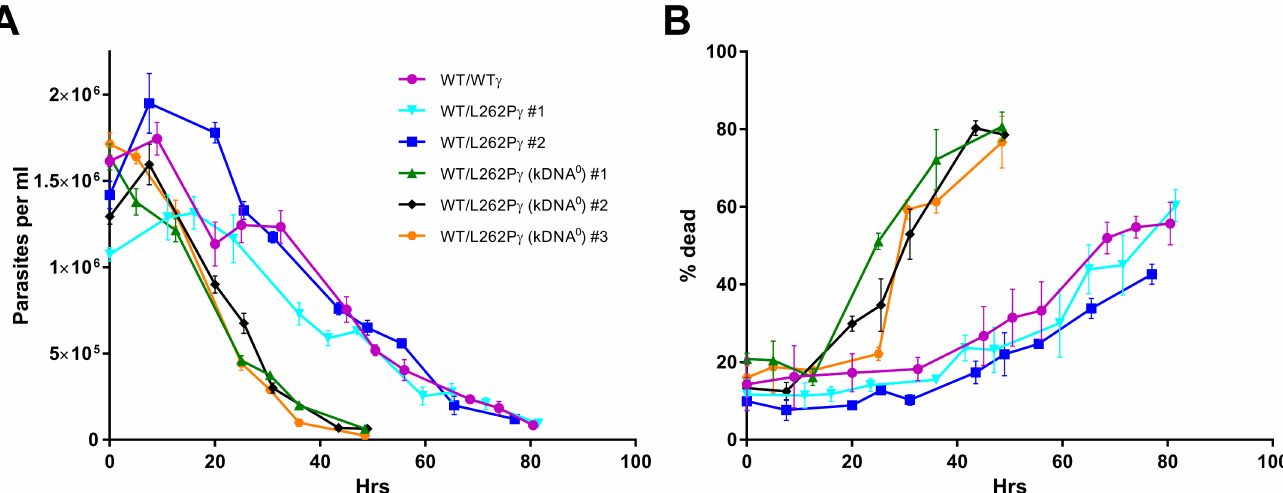
Fig 3. Stumpy form parasites lacking kDNA have a reduced life span in vitro . (A) T . brucei stumpy forms were harvested from mice, purified from blood and cultured in HMI-9 medium containing 50 μ M DFMO to suppress slender form growth. Every 8 h cell numbers were determined in a Coulter particle counter. Cell line WT/L262P γ (kDNA 0 ) #3 had lost its kinetoplast spontaneously, without acriflavine treatment. (B) At every time point shown in panel A, 1x10 6 cells were stained with CFDA-SE and analysed by flow cytometry to determine the percentage of cells that were dead. The gating strategy is shown in supplementary data. Number of replicates n = 3, with error bars showing